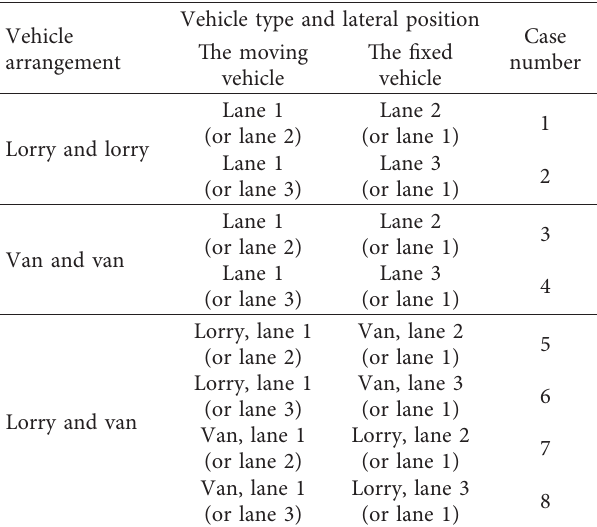
Table 1: Description of the test